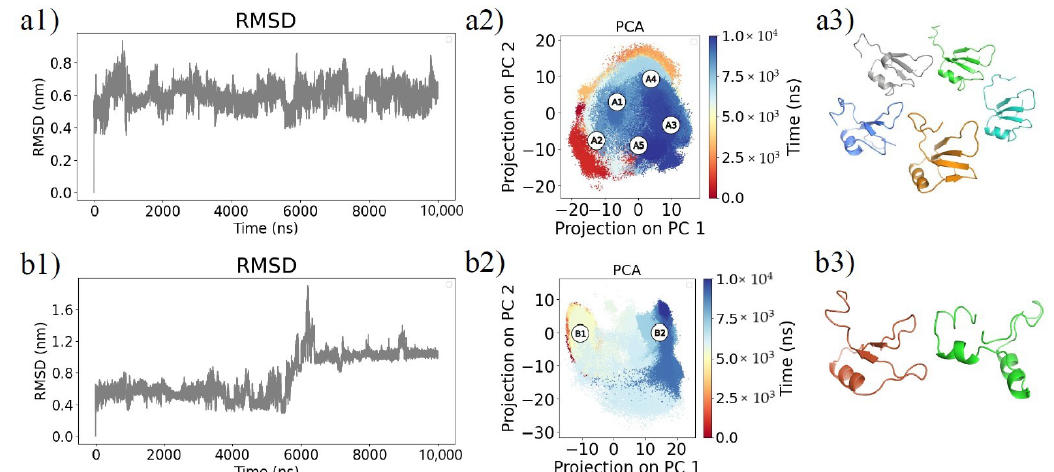
Figure 2. Analysis of the Molecular Dynamics simulations. ( a1 ) Root Mean Square Deviation (RMSD) as a function of time for Fragment A structure with respect to its starting state. ( a2 ) Two-dimensional projection of the sampled conformations in the subspace spanned by the first two Principal Components (PCs) of the covariances of the atomic positions during the simulation. Points are colored from red to blue as simulation time goes from zero to 10 µ s. White circles mark the most representative conformations according to cluster analysis (see Section 4.3). ( a3 ) Cartoon representation of representative conformations marked in ( a2 ). ( b1 – b3 ): same as in ( a1 – a3 ), respectively, but for Fragment